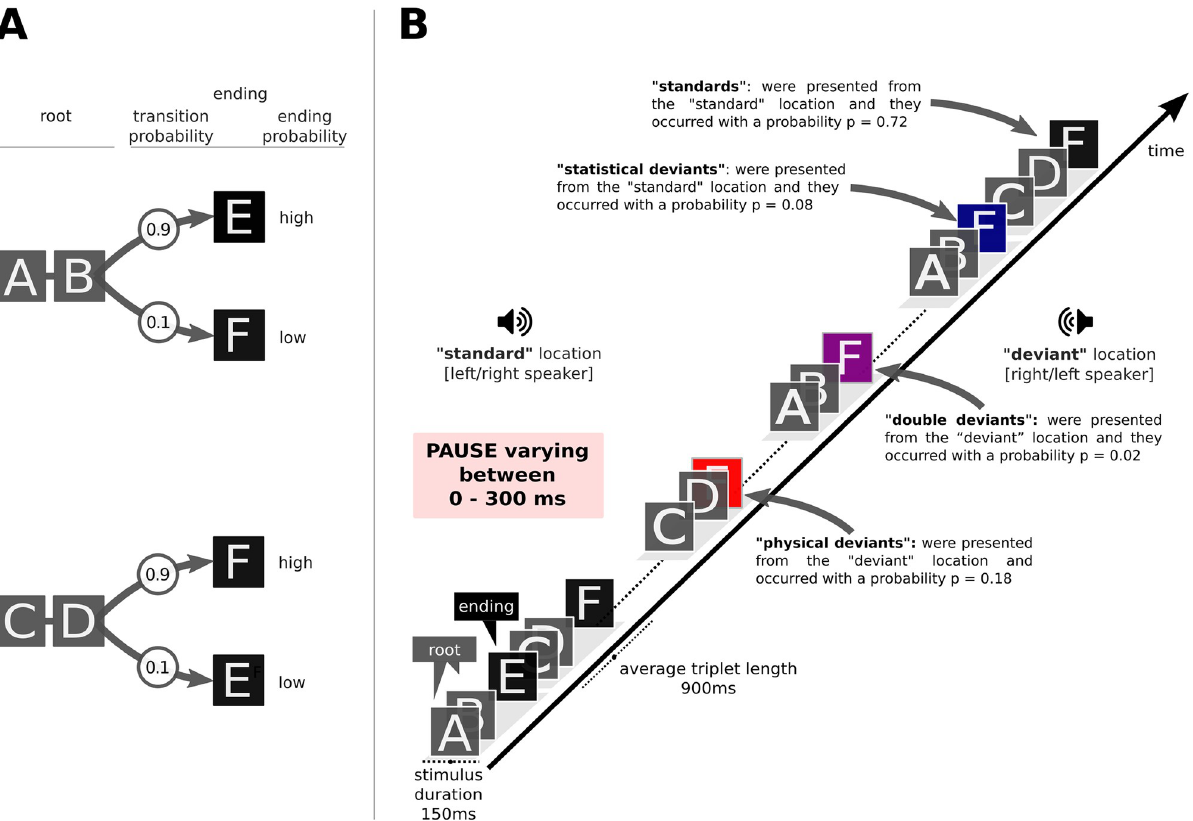
Fig 1. The experimental paradigm. (A) The four triplets generated from the 6 sounds. The letters A to E are used to refer to the sounds. The first two items of the triplet are referred to as “root” and the last item as “ending”. Statistical deviants were created by varying the transition probability from root to ending within two levels, high (p = 0.9) and low (p = 0.1). Triplet roots (AB or CD) are occurring with a constant transitional probability (p = 0.5) after any of the triplet endings (E or F). (B) The auditory stream of pseudorandomly concatenated triplets with standard ending triplets (letter in blackbox), statistical deviant ending triplets (letter in blue box), physical deviants (letter in red box) and double deviants (letters in purple box). Physical deviants were generated by switching speaker, leading to a spatial location change of 60˚ in the azimuth plane.